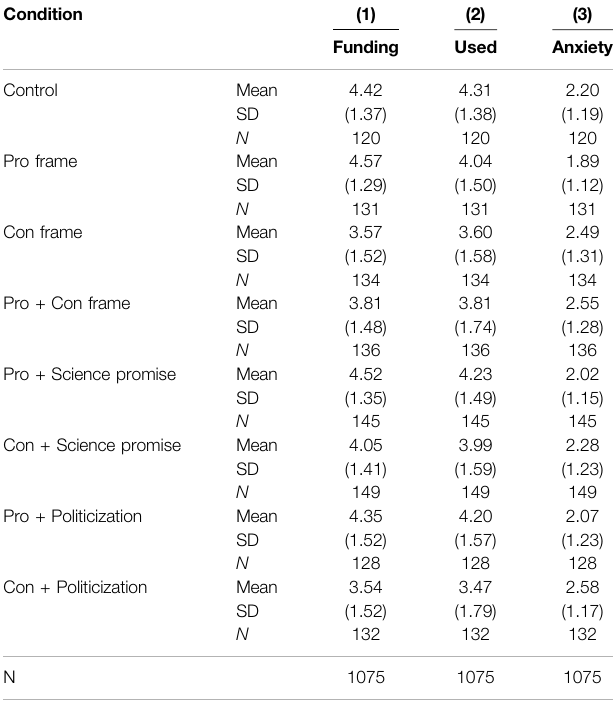
TABLE 3 | Mean Responses Across experimental conditions.